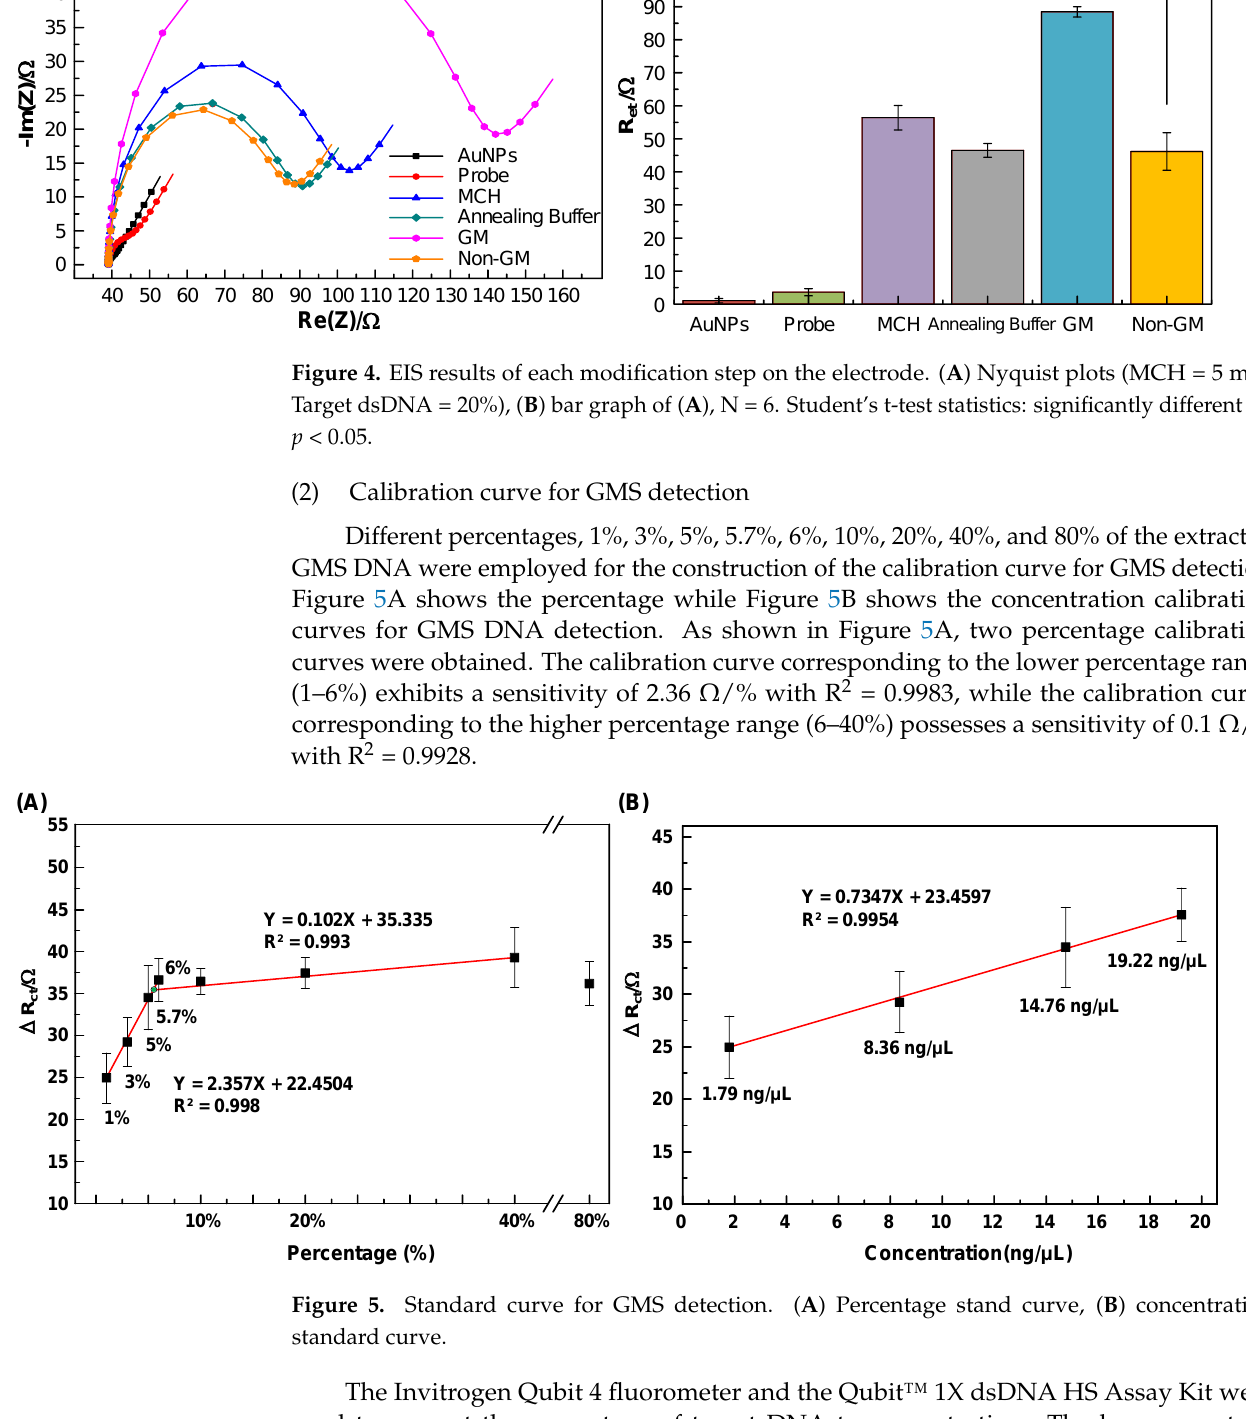
Figure 5. Standard curve for GMS detection. ( A ) Percentage stand curve, ( B ) concentration standard curve. Two target DNA samples, 4% and 5.7%, were used to verify the accuracy of the meas- urement using the concentration standard curve shown in Figure 5B. The results are listed